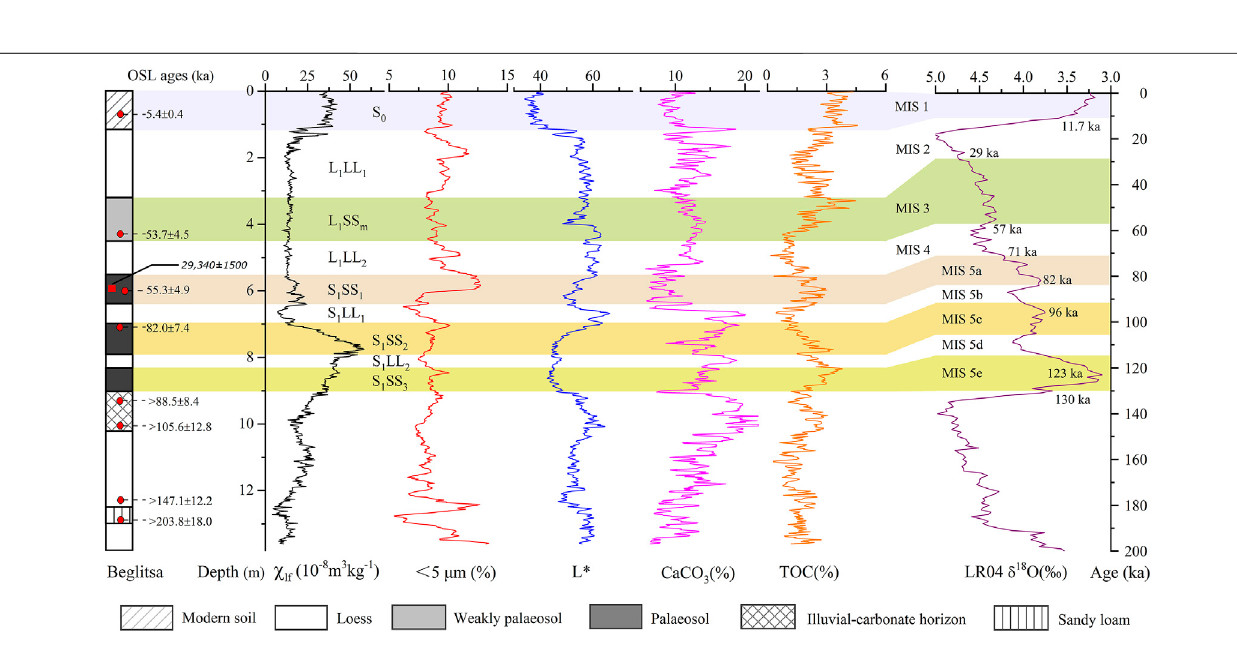
Frontiers in Earth Science |